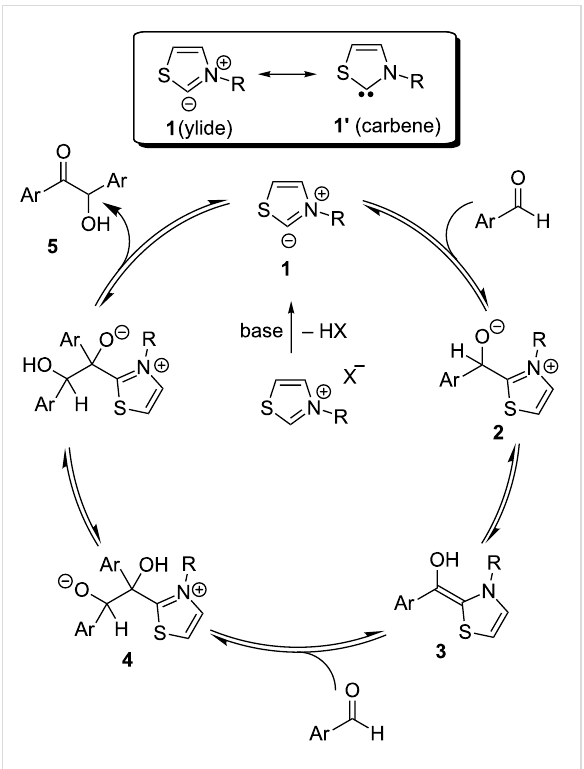
Scheme 1: Breslow’s proposal on the mechanism of the benzoin con-